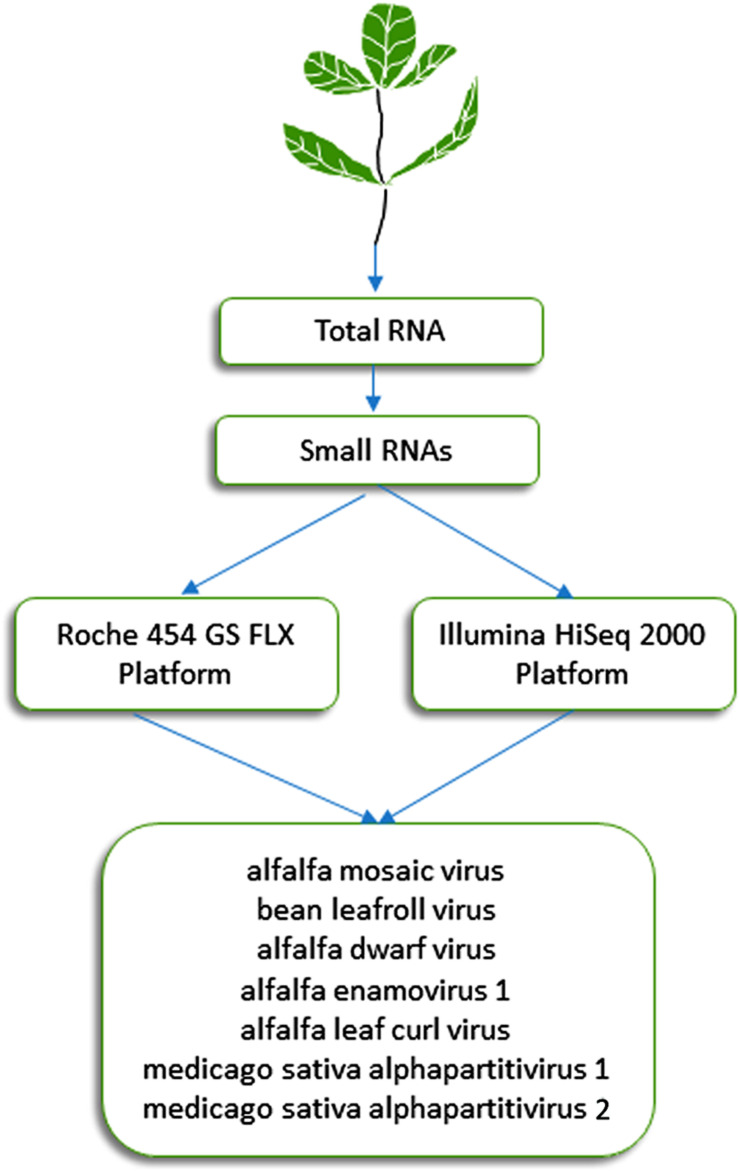
Schematic diagram of the HTS approaches used in Argentina for the identification of seven viruses in alfalfa (Bejerman et al., 2011, 2015, 2016, 2019; Trucco et al., 2014, 2016).